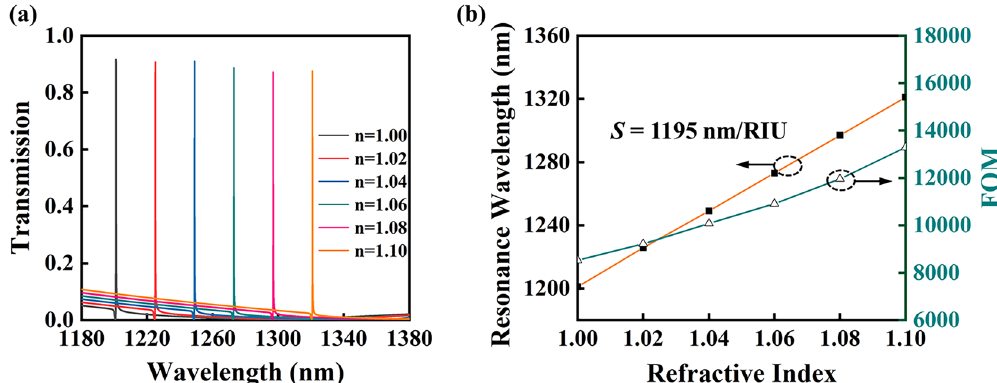
Figure 5. Refractive index sensing performance. ( a ) Transmission spectra of bilayer plasmonic waveguide structure for various ambient refractive indexes. ( b ) Dependence of extracted wavelength position of transmission peak and sensing figure of merit on environmental refractive